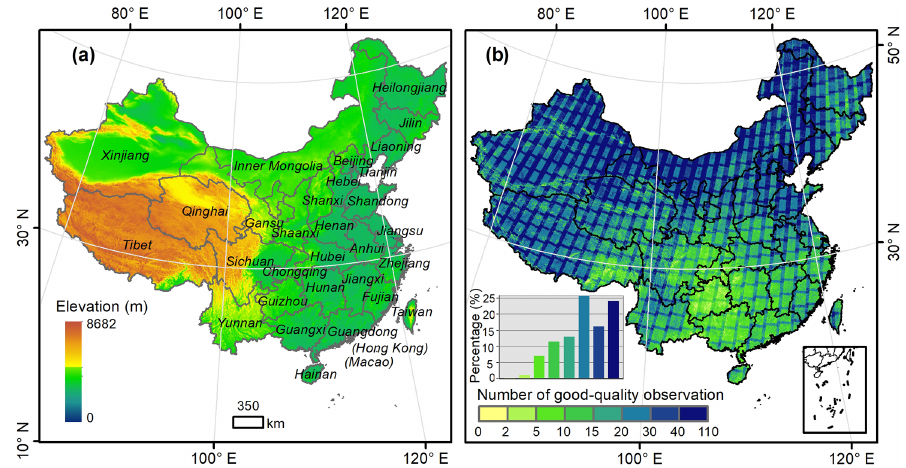
Figure 1. Spatial distribution of provinces and elevation (a) , and numbers of Landsat good-quality observations (b) in China for 2019.